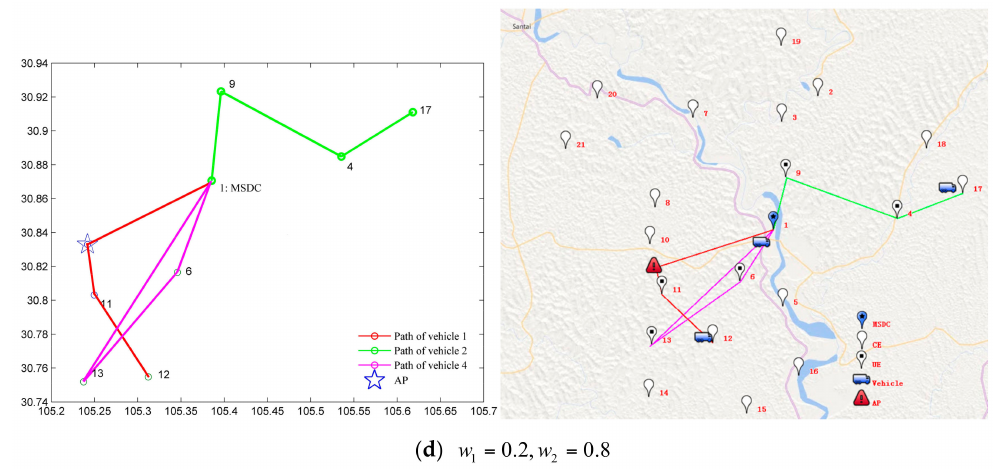
Figure 6. Distribution schemes under different objective